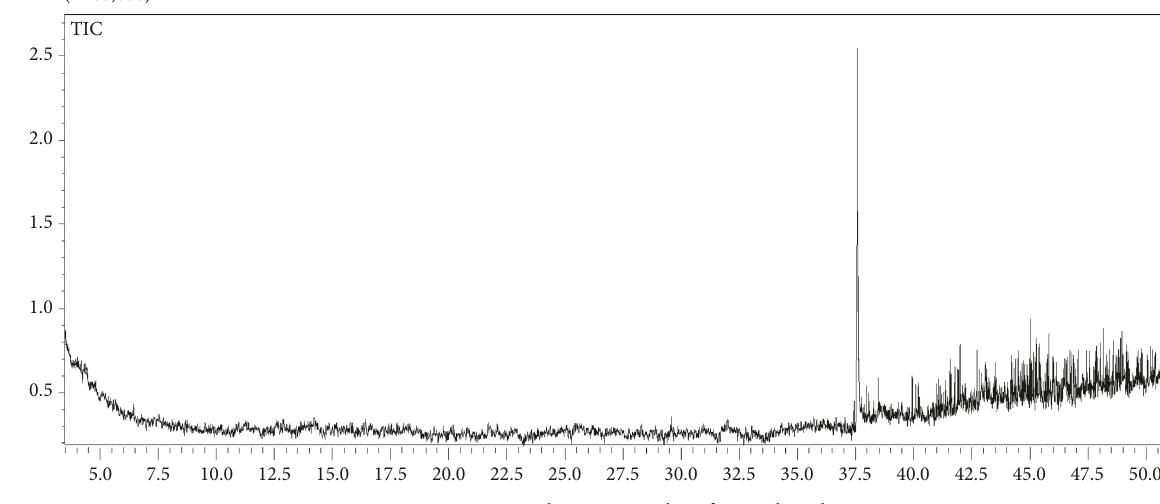
Figure 4: GC-MS chromatography of propolis Table 3: The major constituents of the propolis oil analyzed by GC-MS.